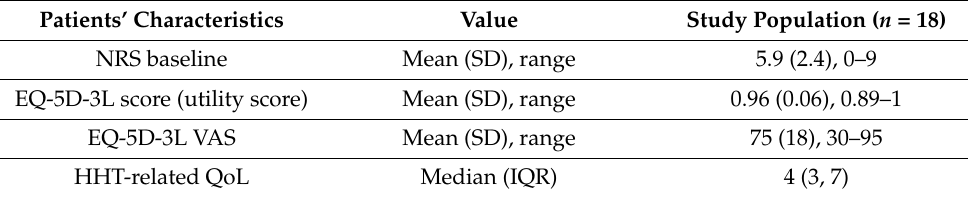
SD = Standard deviation/IQR = Interquartile range.